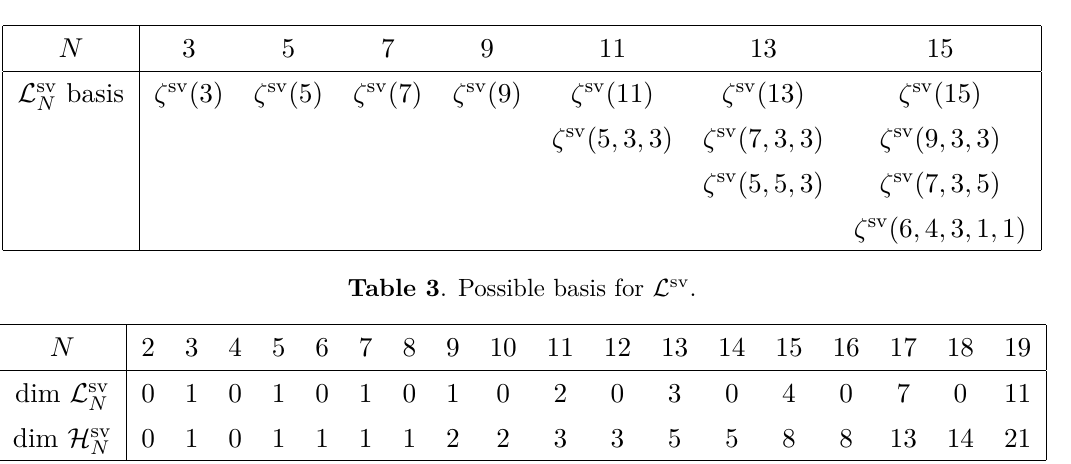
Table 4 . Dimensions of the space H sv ( L sv ) of single-valued multiple zeta values (modulo